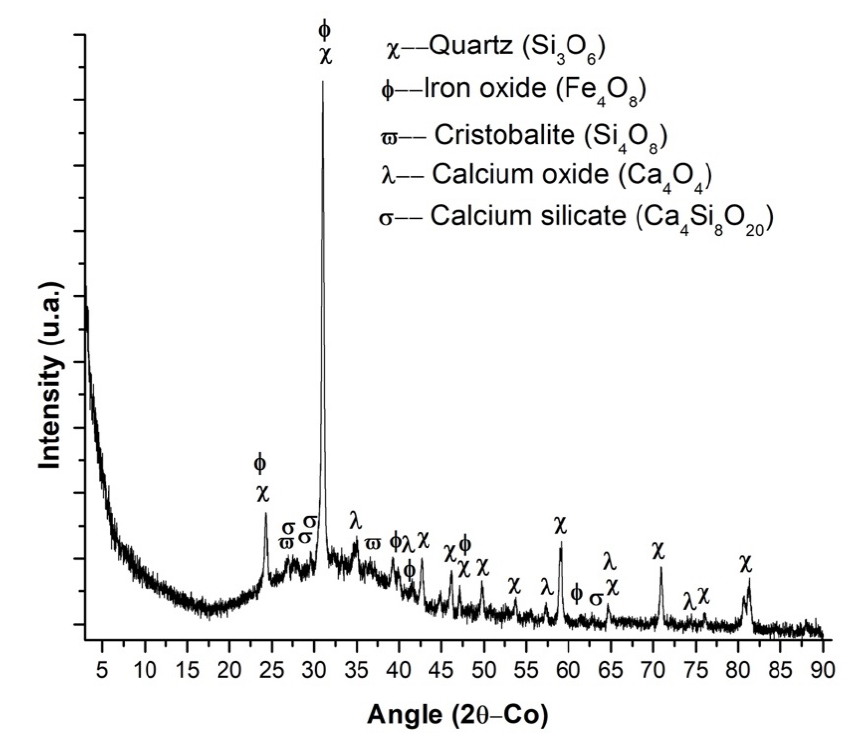
Figure 12. X-Ray diffractogram of a sample before and after the sintering process made with 16 wt % sodium silicate and obtained at 860 ° C for 45 min.